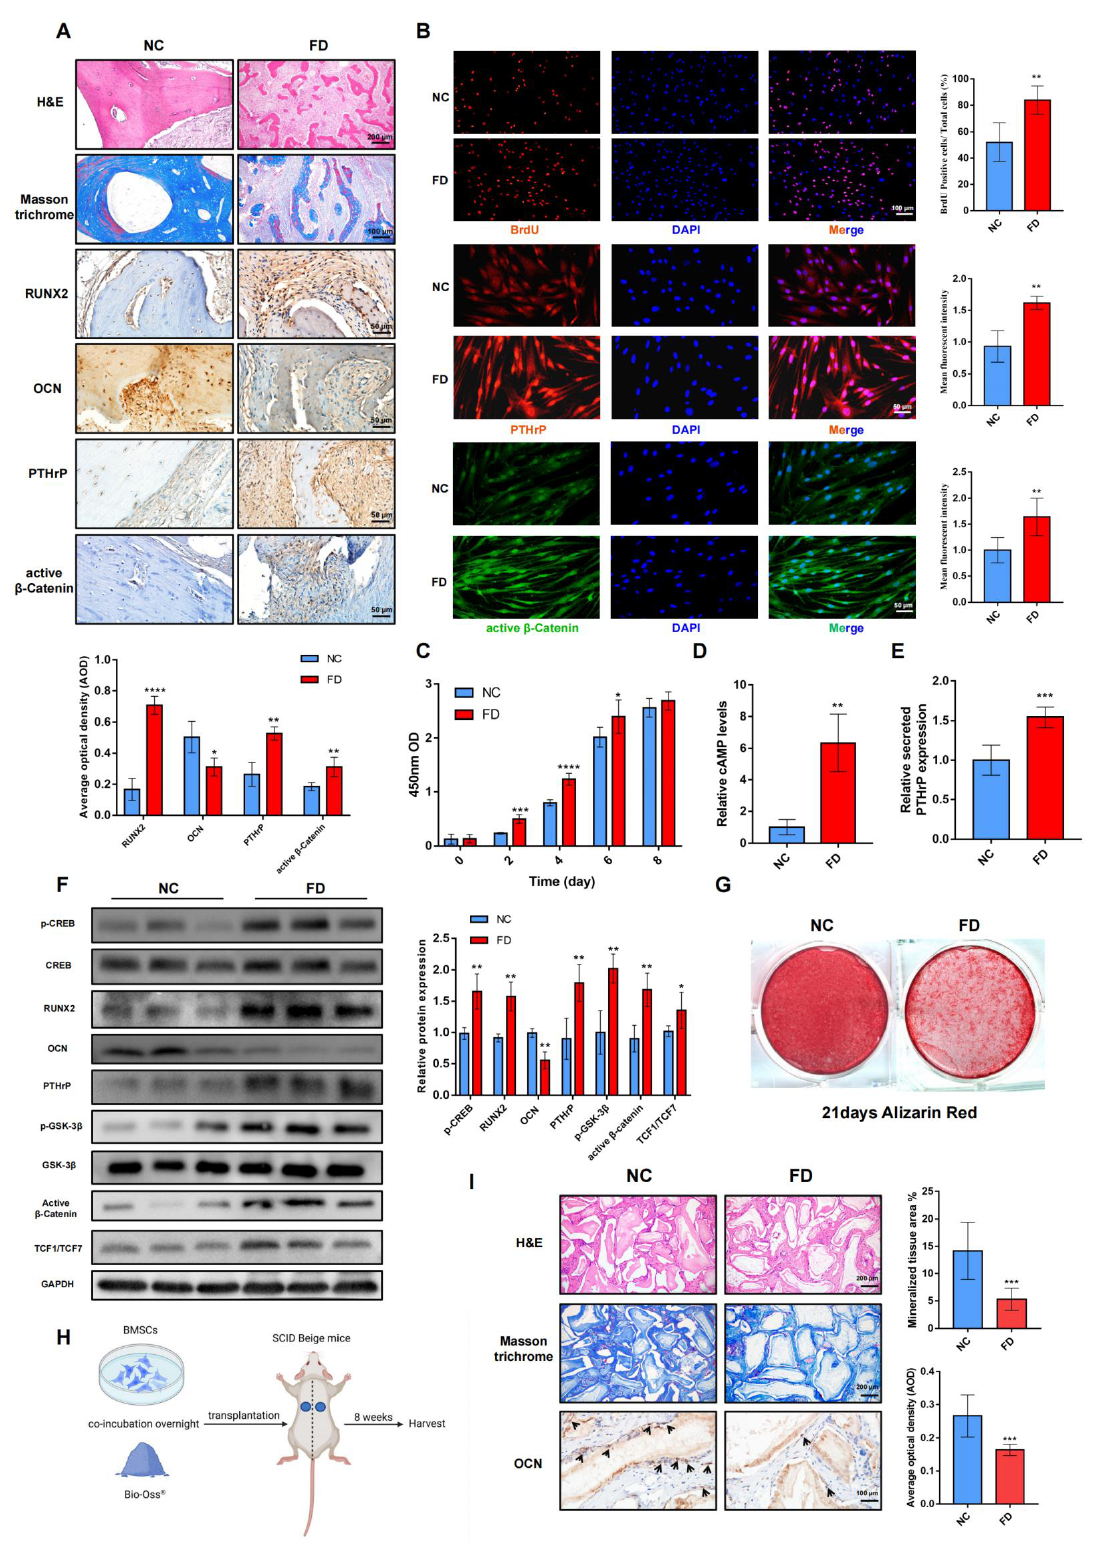
Figure 1. Biological characteristics of FD BMSCs. ( A ): H&E staining, Masson trichrome staining, and immunohistochemistry staining of RUNX2, OCN, PTHrP, and active β -Catenin in normal control patients and FD lesions. ( B ): Immunofluorescence staining of BrdU, PTHrP, and active β -Catenin in NC and FD BMSCs. ( C ): Cell proliferation tested by a CCK8 assay. ( D ): Relative cAMP levels in